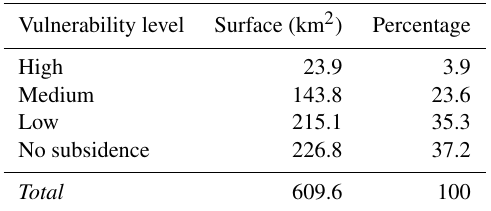
Table 3. Rates of physical vulnerability to fracturing in the Mexico City